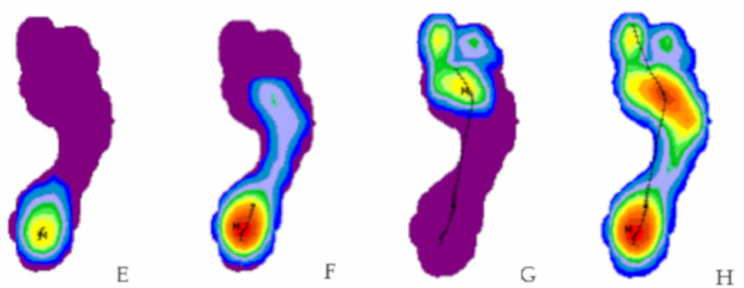
Figure 1. Distribution of pressure and surface at 20% of the stance phase of gait for a representative men ( A ) and a representative women ( E ). The black lines show the COP for each group. Distribution of pressure and surface at 35% of the stance phase of gait for a representative men ( B ) and a representative women ( F ). The white lines show the COP for each group. Distribution of pressure and surface at 92% of the stance phase of gait for a representative men ( C ) and a representative women ( G ). The black lines show the COP for each group. Distribution of pressure and surface of global dynamic footprint for a representative men ( D ) and a representative women ( H